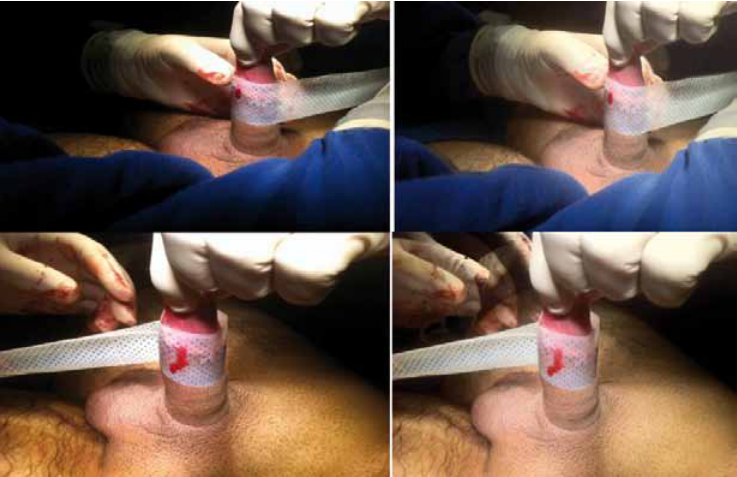
Figure 3 a, b, c and d - Placement of the biopolymer pellicle of sugarcane, involving all penile surface.